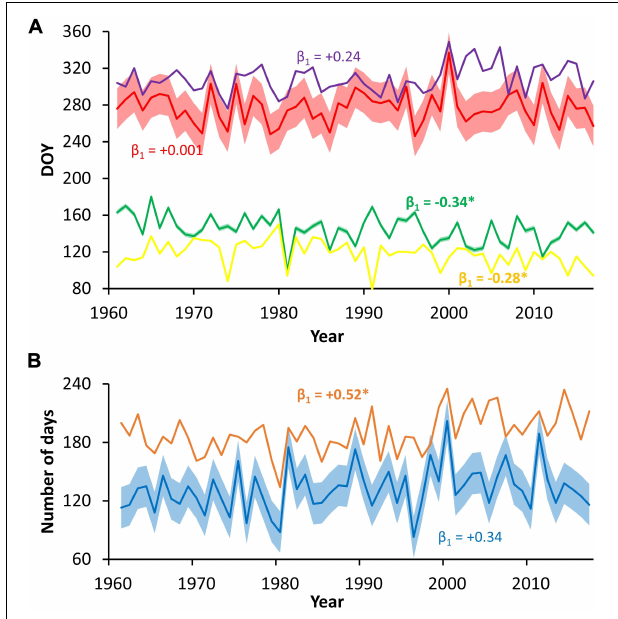
FIGURE 7 | Time series of simulated cambial phenology phases timing (A) and duration (B) ; colors represent the following: yellow–onset of cambial cell growth, green–appearance of the first differentiating cell, red–appearance of the last differentiating cell, purple–cessation of cambial cell growth, blue–period between appearance of the first/last differentiating cell, brown–period between onset/cessation of cambial cell growth; error belts around series of the first/last occurrence of differentiating cell and period between them indicate RMSE of estimates; β 1 = slope of linear regression, significant slopes are given in bold with